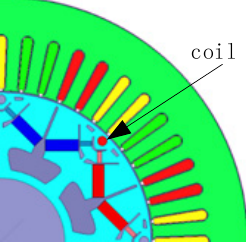
Figure 5. Add excitation winding. The equivalent magnetic circuit is shown in Figure 6. F e is the equivalent magnetic motive force generated by the excitation current. The magnetic motive force interacts with the magnetic coercive force F C and F V of the high- and low-coercive force in the magnetic circuit. To a certain extent, it can magnetize and demagnetize the low-coercive force permanent magnet to weaken the coupling effect. In the model of the positive parallel magnetic circuit shown in Figure 6a, the magnetic flux Φ ev generated by the excitation potential in the magnetic circuit of a low-coercive permanent magnet is known as: Φ = F · ev e in which, R C (cid:48) and R V (cid:48) represent the magnetic resistance of high- and low-coercive per- manent magnets in the coupling effect; R r is the magnetic resistance parallel value of the uncoupled circuit; and R e is the excitation resistance. Similarly, in Figure 6b, the flux (cid:48) generated by the excitation magnetomotive force is equal to Φ Φ ev Equation (11) that the excitation potential F e can indeed change the magnetic flux of a low- coercive permanent magnet, change its operating point, and weaken the cross-coupling effect in both the forward and reverse parallel